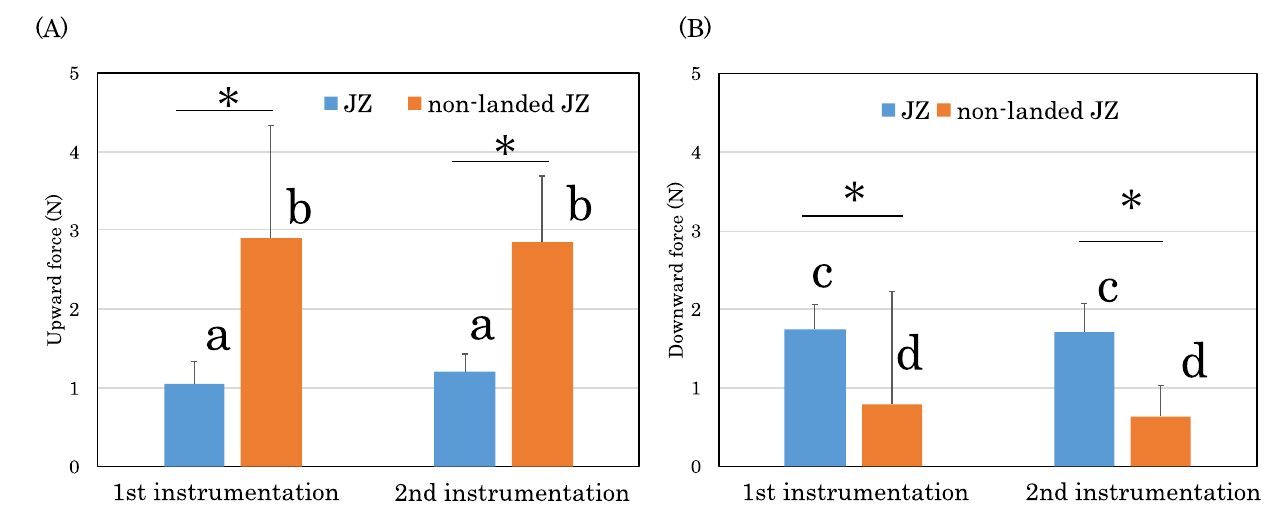
Figure 5. Maximum values of upward force ( A ) and downward force ( B ) during root canal instrumentation. Data represent the mean and standard deviation ( n = 10). * p < 0.05 within the same instrumentation sequence. Different lowercase letters are significantly different within the same instrument ( p < 0.05).